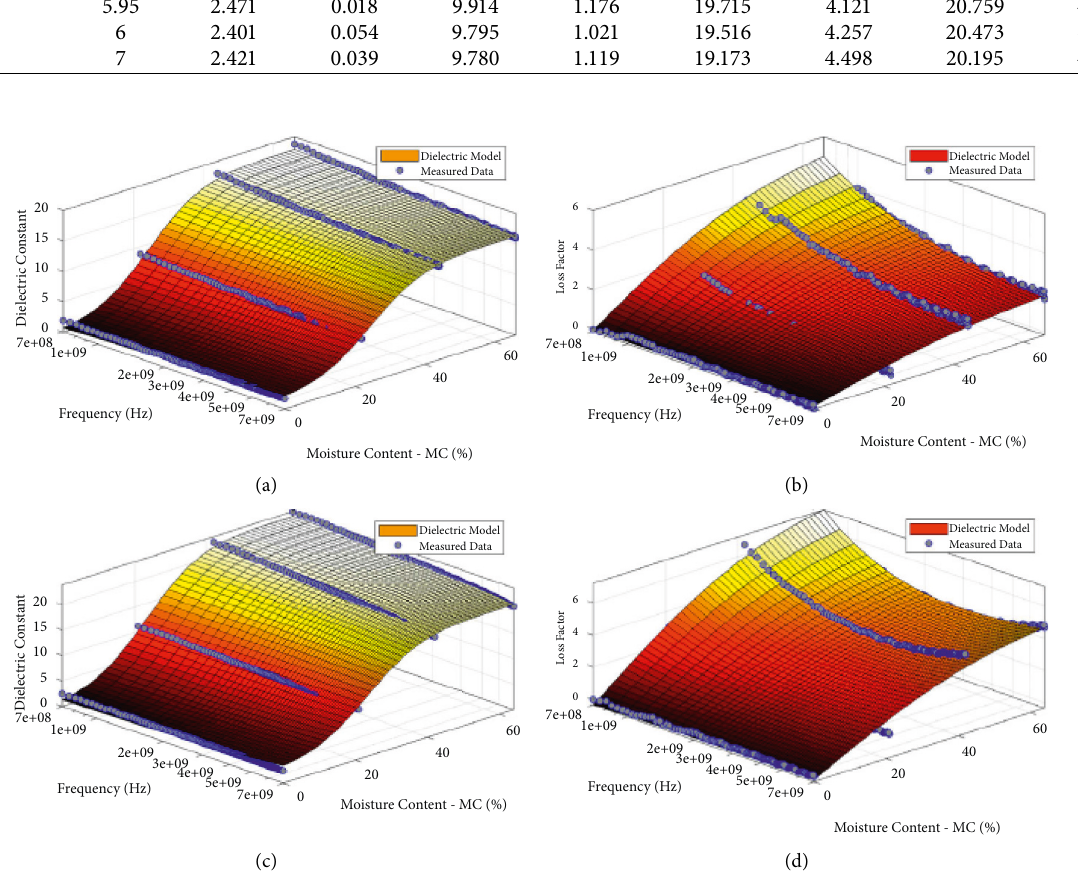
Figure 3: Comparisons between anticipated and observed dielectric characteristics for JU loam soil and Bangalore clay loam